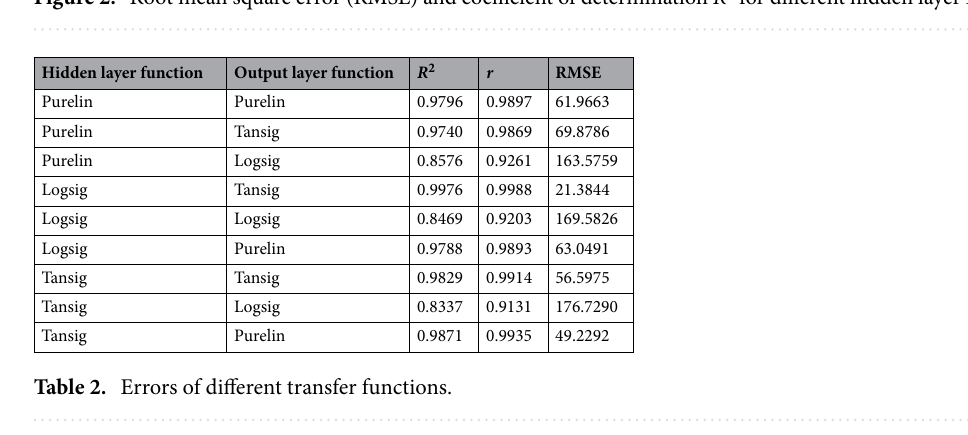
Figure 2. Root mean square error (RMSE) and coefficient of determination R 2 for different hidden layer nodes.